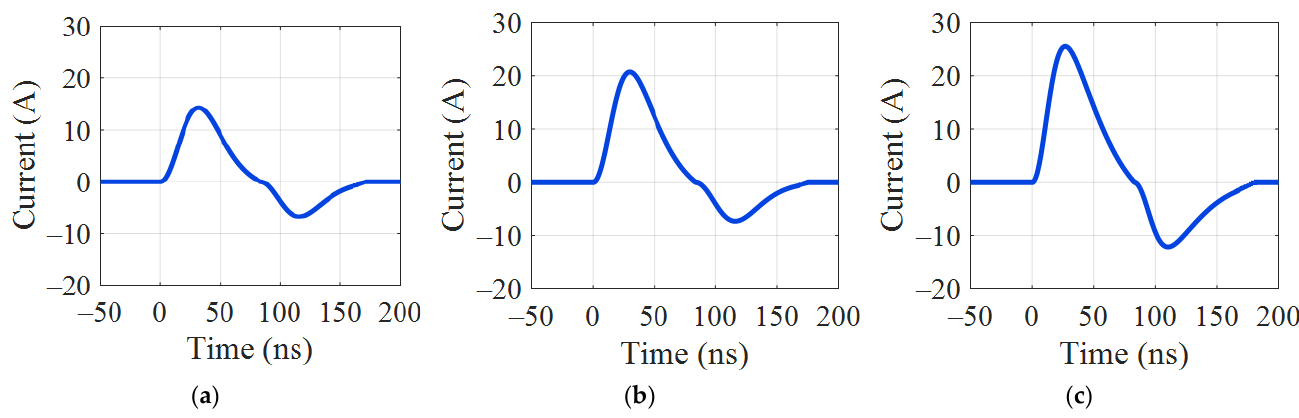
Figure 15. Simulated excitation current for moderate and serious EMD situations: ( a ) moderate situation with parameters: α = 0.0217, β = 0.0413, A + = 14.580, R A = 2.2, t r = 18.731 ns, t w = 40.949 ns; ( b ) severe situation with parameters: α = 0.0196, β = 0.0489, A + = 19.218, R A = 2.2, t r = 17.522 ns, t w = 42.386 ns; ( c ) critical situation with parameters: α = 0.0182, β = 0.0588, A + = 26.252, R A = 2.2, t r = 15.419 ns, t w = 43.805.